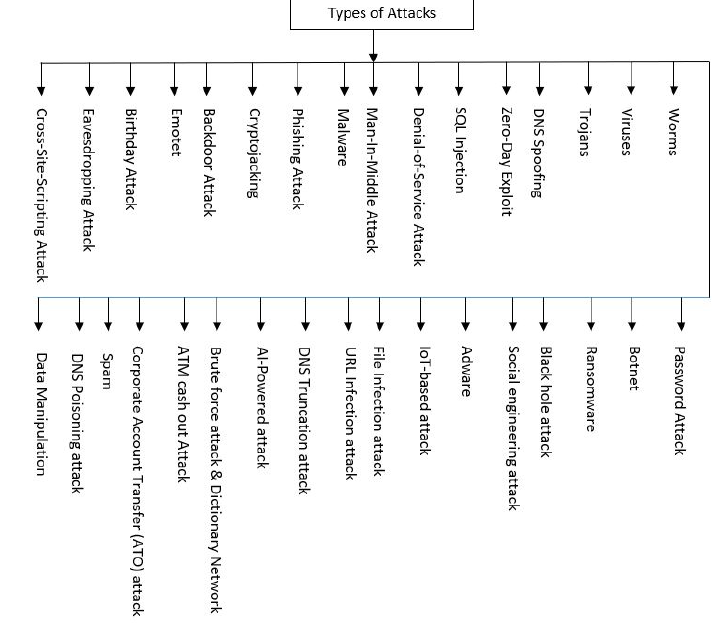
Figure 2. Possible Types of Cyber Threat.